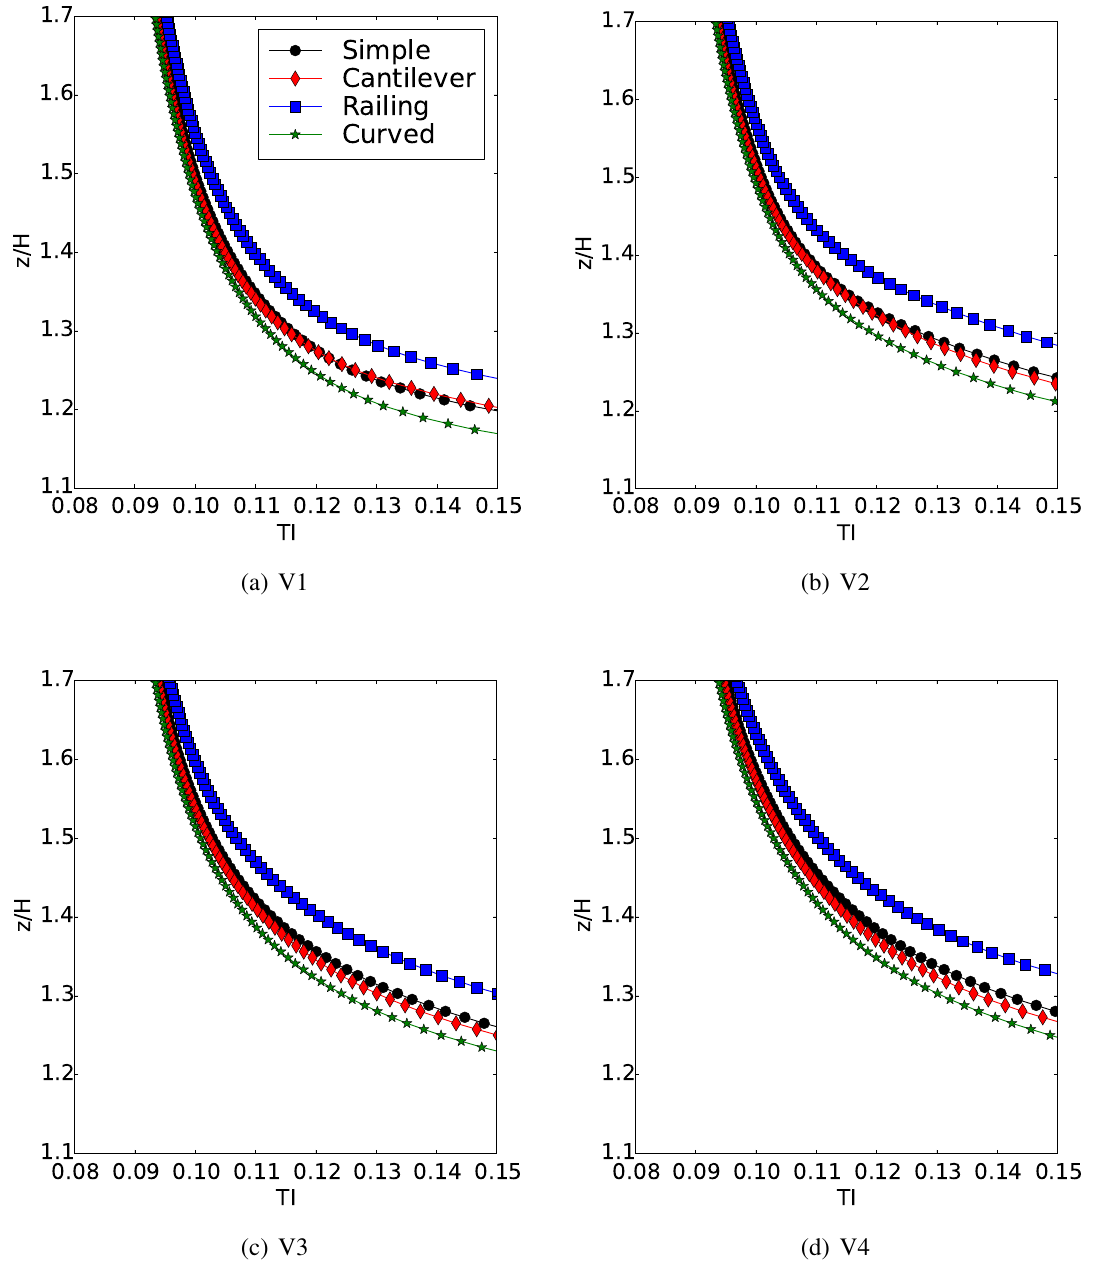
Figure 20. Comparison of T I below the limit of T I < 0 . 15 between the different roof edge shapes investigated at the vertical section at the center of the